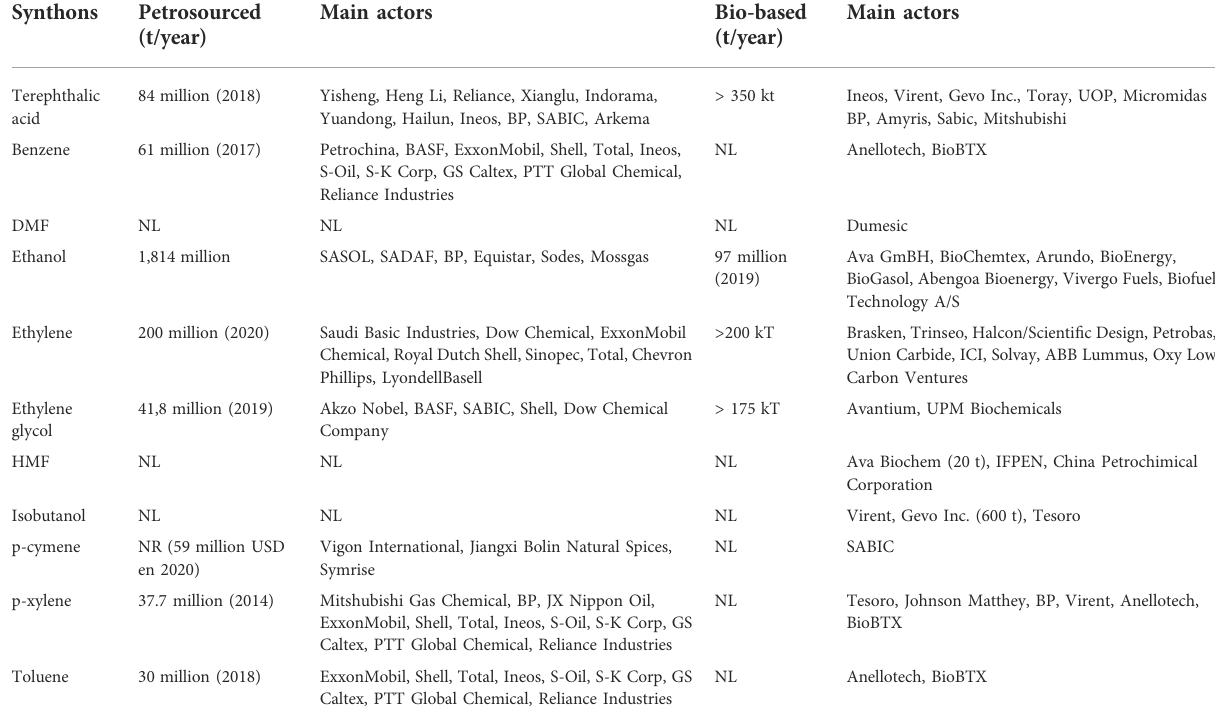
TABLE 4 Production capacity and main actors for the synthesis of the studied synthons (NL means “ not listed ” ).